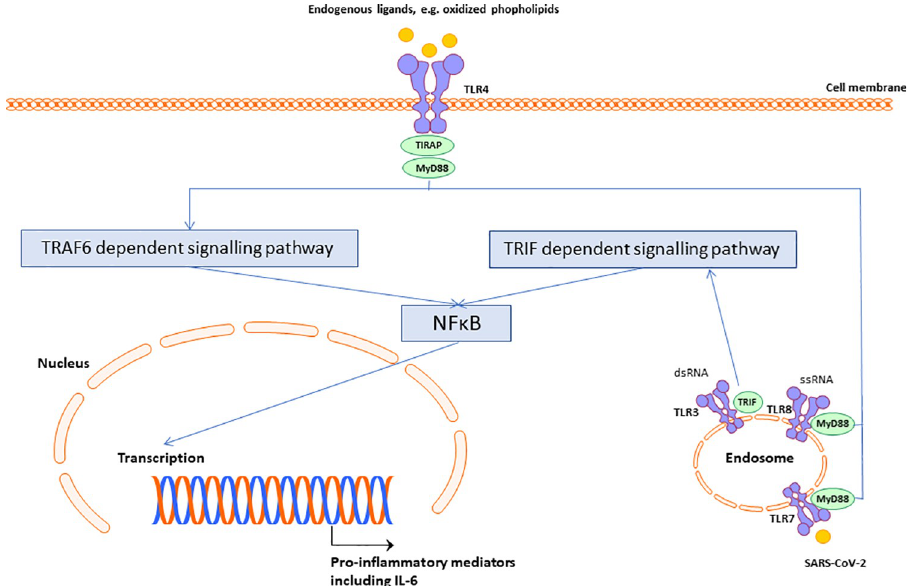
Fig 1. Proposed simplified schematic representation of SARS-CoV-2 induced intracellular pro-inflammatory signalling pathway. Abbreviations: IL; interleukin, MyD88; myeloid differentiation factor 88, NFkB; nuclear factor- kappa B, TIRAP; toll/interleukin-1 receptor domain-containing adaptor protein, TLR; toll-like receptor, TRAF6; TNF Receptor Associated Factor 6, TRIF; TIR-domain-containing adapter-inducing interferon- β , ssRNA; single-strand ribonucleic acid, dsRNA; double-strand ribonucleic